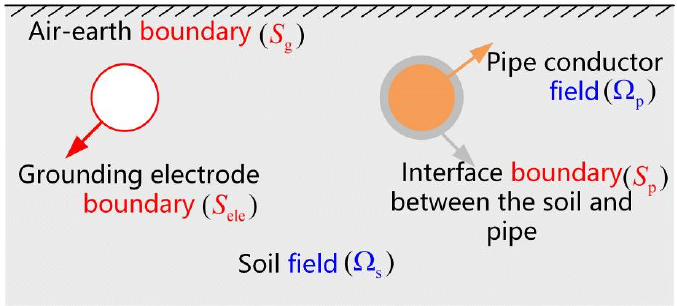
Figure 3. Schematic diagram of the boundary value problem.